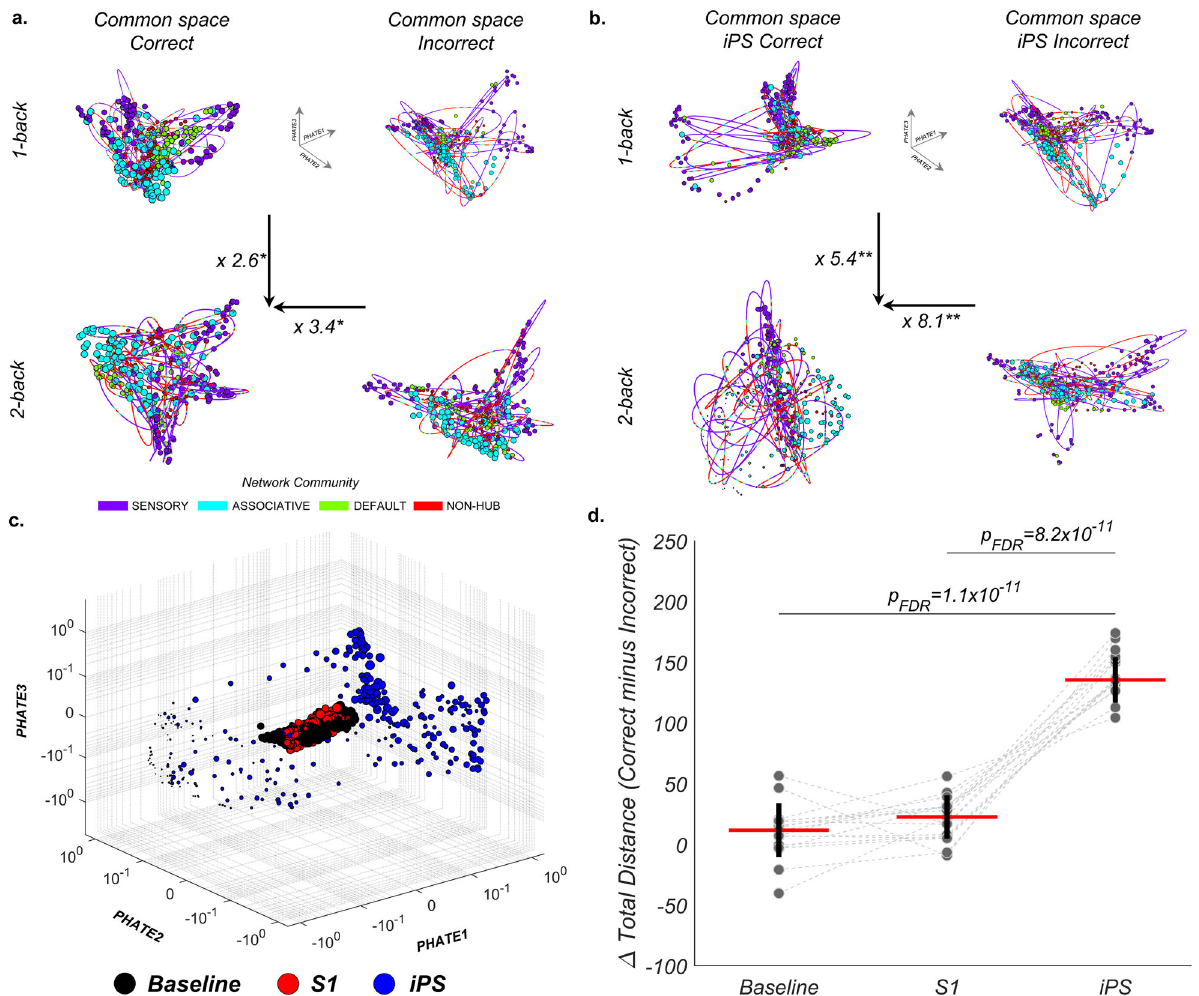
Fig. 2 Recon fi guration of the low-dimensional trajectories of brain activity as a function of working memory load, task performances, and local neural perturbations. a A shared (common) embedding space allows an across-session comparison of the state-space embedding of trajectories of brain activity supporting “ correct ” and “ incorrect ” trials. A general expansion of the trajectories of activity (i.e., utilizing data from all experimental sessions) is required to support “ correct ” trials in the 2-back condition (2.6 times greater than 1-back trials and 3.4 times greater than ‘ incorrect ’ trials in the same conditions). b Analysis of ‘ correct ’ and ‘ incorrect ’ trials for the iPS session showed that a signi fi cant expansion of low-dimensional trajectories of brain activity following a targeted neural perturbation (TMS on iPS; baseline and S1 shown in Supplementary Fig. 4a) supported successful 2-back performance (5.4 times greater than 1-back trials and 8.1 times greater than “ incorrect ” trials). For panels ( a and b ), asterisks indicate signi fi cant (*p FDR < 0.001) and highly signi fi cant values (**p FDR < 1 × 10 − 6 ). c The signi fi cant expansion of trajectories following TMS on iPS involved the three PHATE dimensions ( ‘ correct ’ trials in the 2-back condition, visualized in log space, same embedding space across experimental sessions). d At the participant-level ( n = 17, examined over three experimental sessions), comparison of the lengths of trajectories supporting distinct working memory loads (2-back minus 1-back, subtracting ‘ incorrect ’ trials; median represented by red line; within-session S.D. shown with vertical black lines) showed that “ correct ” trials following TMS on iPS were linked to a greater expansion of the low-dimensional trajectories as a function of load compared to baseline and S1 trajectories. Comparisons of trajectory lengths across sessions were tested with two-sided paired t -tests, with signi fi cance values corrected for multiple comparisons. Source data are provided as a Source data fi p = 2.8 × 10 − 35 ; post-hoc paired t-test: iPS > baseline p FDR = 1.1